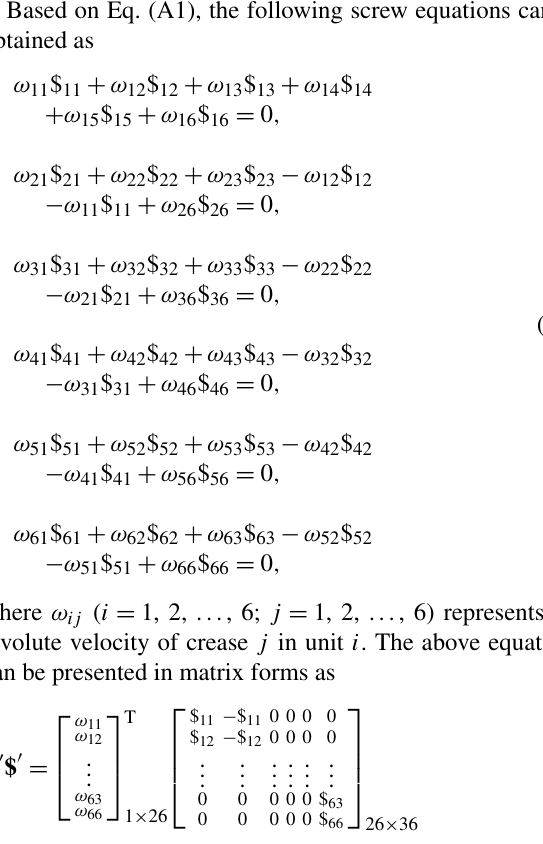
where M represents the mobility, n represents the number of components including the frame, g represents the number of kinematic pairs, and f i represents the DOF of crease i . Similarly, U B -B and U B -C can also be proved to be 1-DOF. Furthermore, the mobility of the deployable string is an- alyzed. The topological constraint graph of the deployable string is shown in Fig. A2, where the circles represent panels, the arrows represent creases, U i ( i = 1, 2, ..., 6) represents the unit i , $ ij ( i = 1, 2, ..., 6; j = 1, 2, ..., 6) represents the motion screws of crease j in unit i